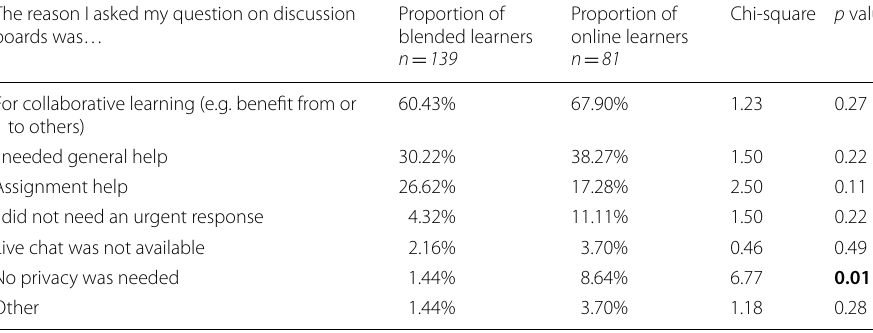
Bold indiactes significant value ( p <